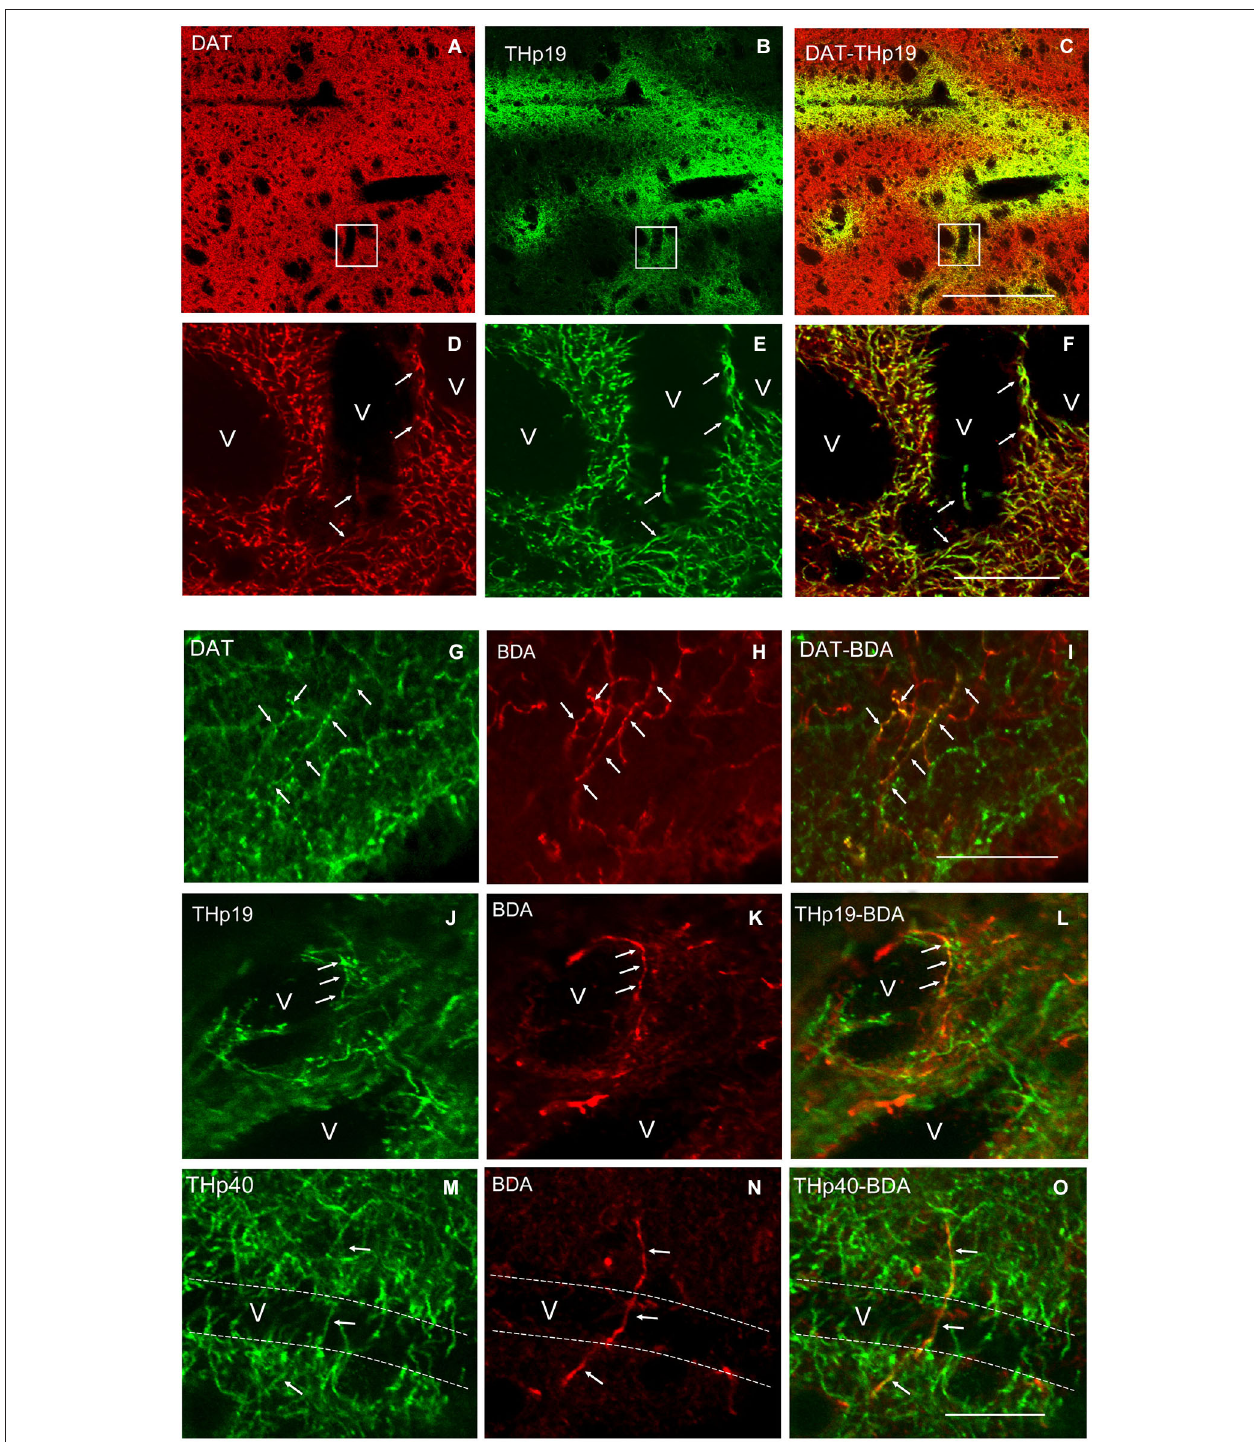
BDA showing that BDA-positive ascending axons (H) and perivascular terminals (K,N) are immunoreactive for DAT (G–I) , THp19 (J–L) and THp40 (M–O) . v, vessel lumen. Dotted lines in (M–O) indicate the probable localization of the vessel wall. Bar in (C) (for A–C ), 130 µ m; in (F) (for D–F ), 40 µ m; in (I) (for G–I ), 40 µ m; in (O) (for J–O ), 40 µ